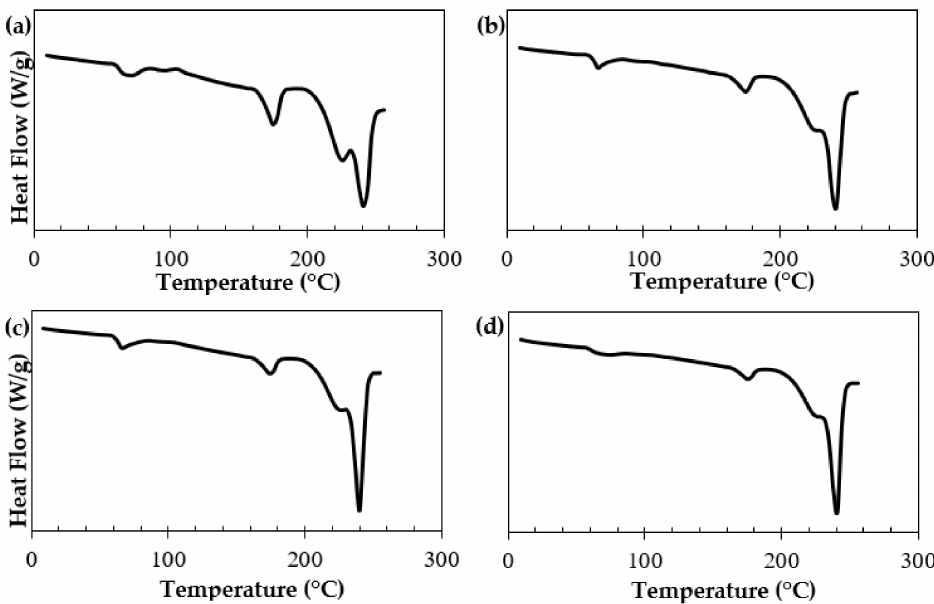
Figure 10. The DSC thermograms of SC PLA at sample collection times of ( a ) 5 min, ( b ) 10 min, ( c ) 20 min, ( d ) 40